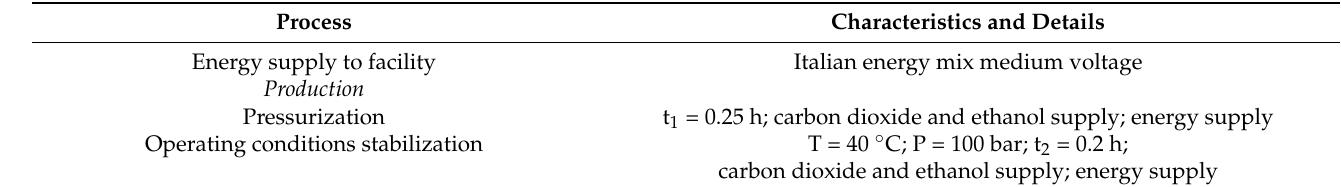
Table 1. Process details and